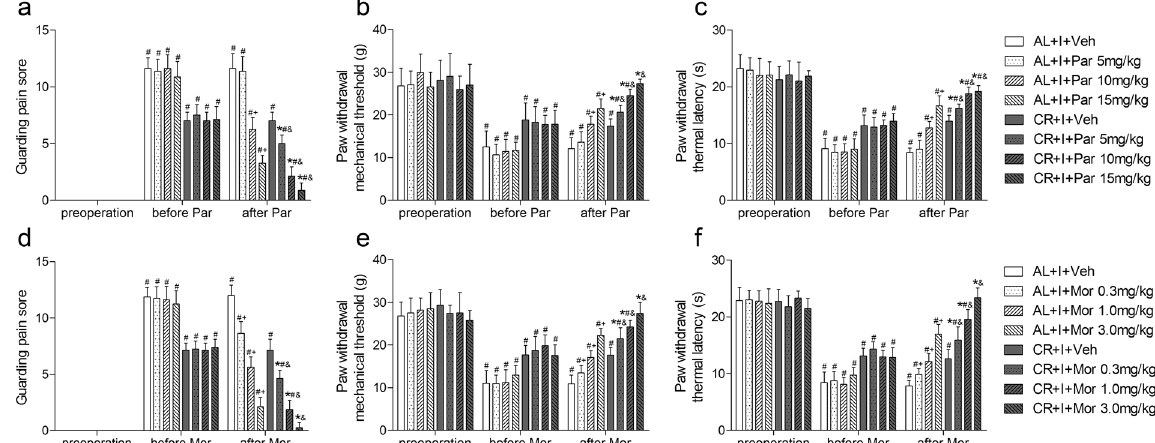
Figure 3. Effects of caloric restriction on the efficiency of analgesics after incision. A single intraperitoneal injection of parecoxib dose-dependently attenuated nonevoked pain ( a ), mechanical allodynia ( b ) and thermal hyperalgesia ( c ) (n = 8). A single subcutaneous injection of morphine dose-dependently attenuated nonevoked pain ( d ), mechanical allodynia ( e ) and thermal hyperalgesia ( f ) (n = 8). Pain behaviors were assessed before incision, before administration of analgesics on postoperative day 1 and at 1 h after administration. Values expressed as mean ± SD. AL + I + Par: AL + I rats received different doses of parecoxib (Par); CR + I + Par: CR + I rats received different doses of parecoxib; AL + I + Mor: AL + I rats received different doses of morphine (Mor); CR + I + Mor: CR + I rats received different doses of morphine; AL + I + Veh: AL + I rats received an equivalent volume of vehicle (saline); CR + I + Veh: CR + I rats received an equivalent volume of vehicle (saline). Significant difference was revealed after two-way ANOVA ( * P < 0.05 in comparison of CR + I rats with AL + I rats received the identical dose of analgesic, # P < 0.05 compared with baseline before incision, + P < 0.05 compared with group AL + I + Veh, & p < 0.05 compared with group CR + I + Veh, Bonferroni post hoc